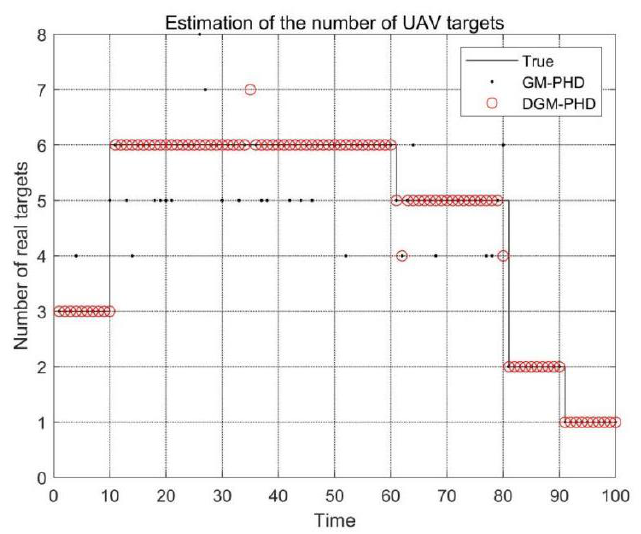
Figure 7. Comparison of estimated Number of UAV in observation Period.